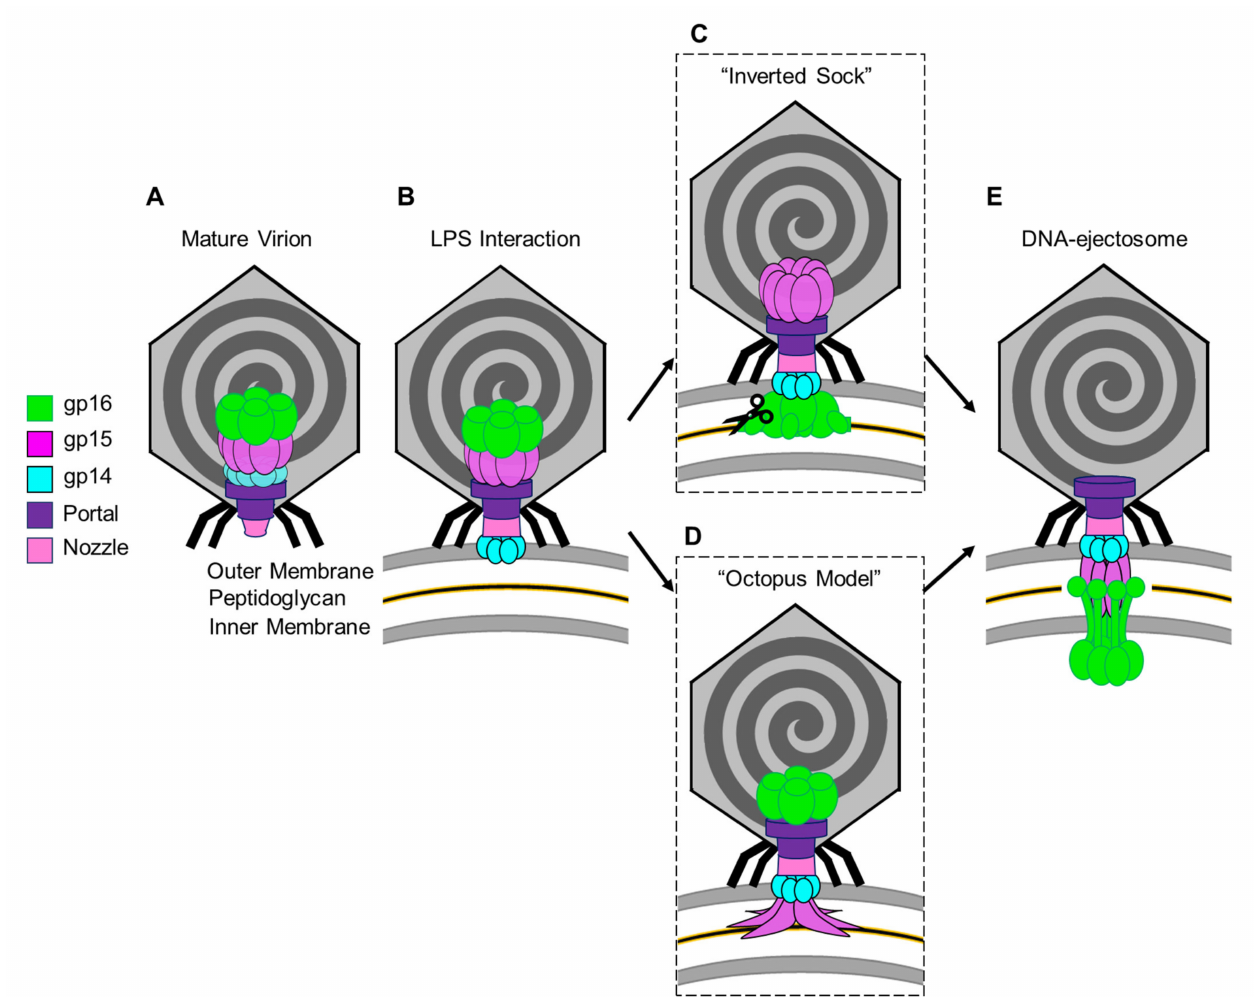
Figure 6. Models for the T7 ejection proteins assembly to form a DNA ejectosome. ( A )The mature T7 virion shown with the internal core stack concentrically arranged on the portal protein. ( B ) Tail fiber interactions with LPS on the host E. coli surface initiate conformational changes in the nozzle and portal protein and eject gp14 to form an outer membrane pore. ( C ) In the “inverted sock” model, gp16 exits next, in the “inverted sock model”, and cleaves the peptidoglycan layer within the host periplasm, followed by gp15’s exit to form the periplasmic tunnel (PT). ( D ) Alternatively, in the “octopus model” gp15 exits after gp14, forming a partially stabilized hexamer prior to gp16’s exit and cleavage of the peptidoglycan barrier in the periplasm. ( E ) Both models end with the formation of the DNA-ejectosome which includes the gp14 outer membrane pore connected to the gp15:gp16 periplamic tunnel which traverses the host inner membrane and projects the gp16-C cytoplasmic hub for viral genome